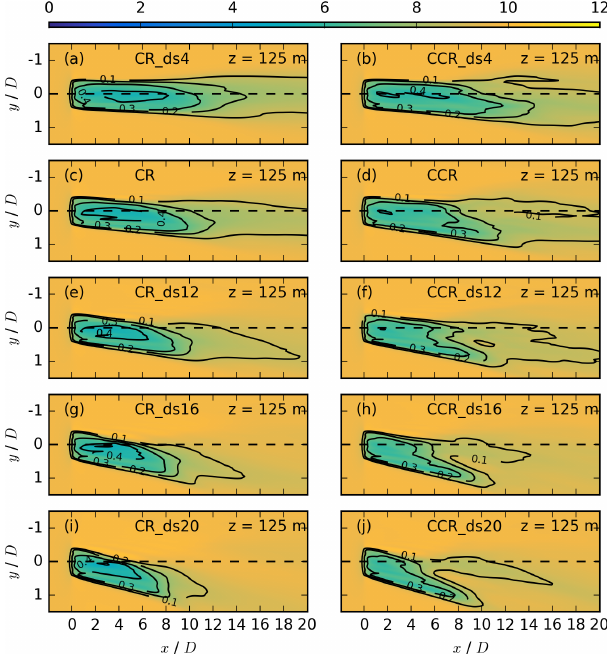
in meters Figure 11. Contours of the streamwise velocity u i,j,k ∗ per second for different directional shears at z = 125m for the same simulations as in Fig. 10. The black contours represent the velocity deficit VD i,j,k at the same vertical ∗ at the same vertical lo- ∗